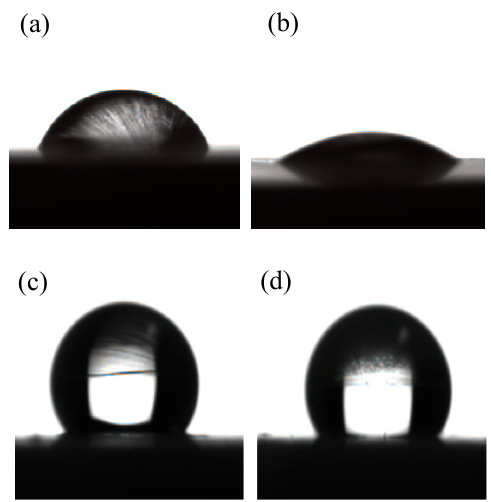
Figure 5. Contact angle of water droplets on ( a ) bare copper surface; ( b ) H 3 PO 4 -treated copper surface; ( c ) copper surface with 1-dodecanethiol SAM; and, ( d ) H 3 PO 4 -treated copper surface with 1-dodecanethiol